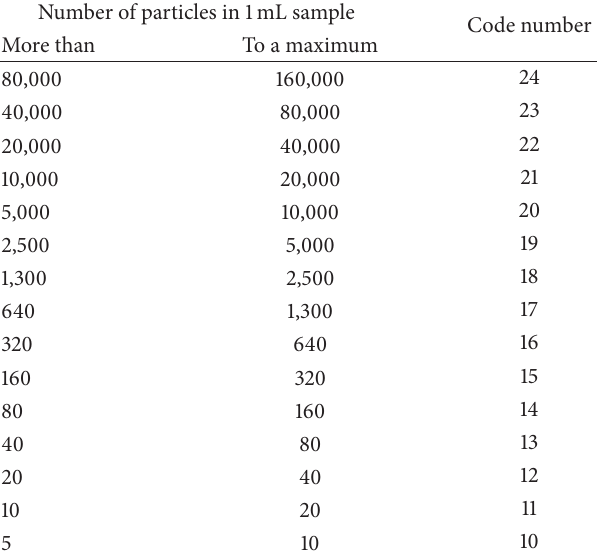
Table 1: Representation of the number of solid particles in the lubricant by code classification.